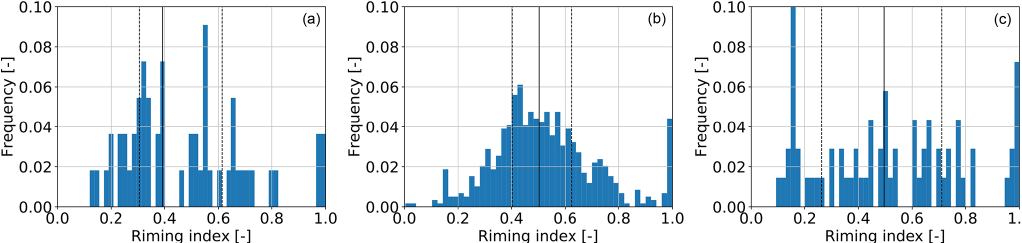
Figure 9. Distribution of the riming index for all particles between (a) 03:00 and 04:00UTC, (b) 06:00 and 08:00UTC, and (c) 09:00 and 11:00UTC. The dashed lines show the lower and upper quartiles; the solid line shows the median of the distribution.